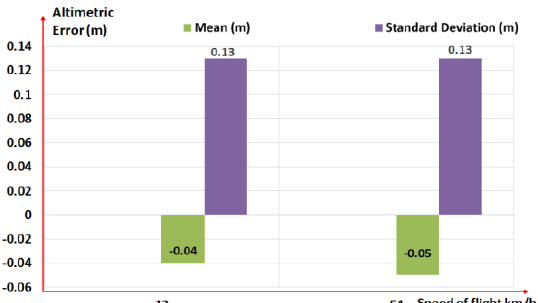
Figure 6: Impact of different speed flight (13 and 54 km/h) on DSM